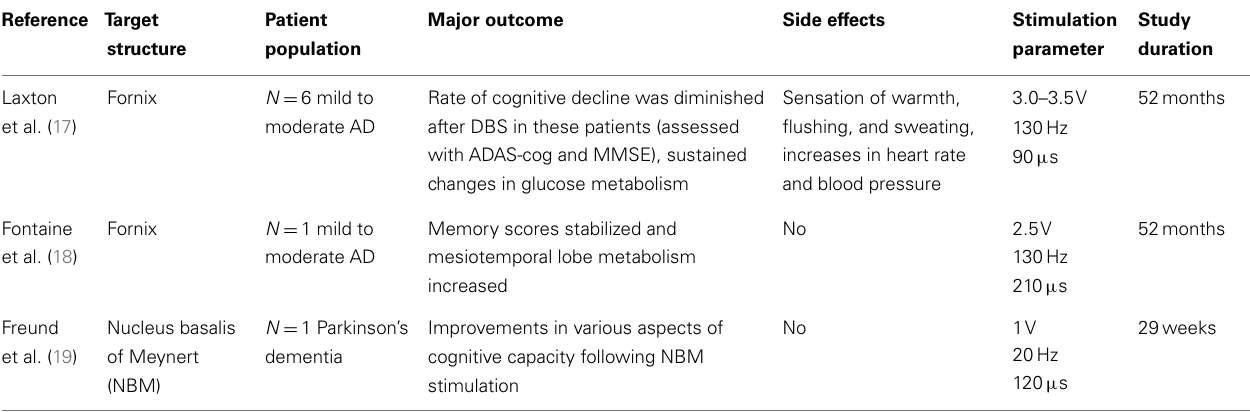
Table 1 | Studies in man investigating the effects of DBS primarily addressing cognitive performance in patients suffering from